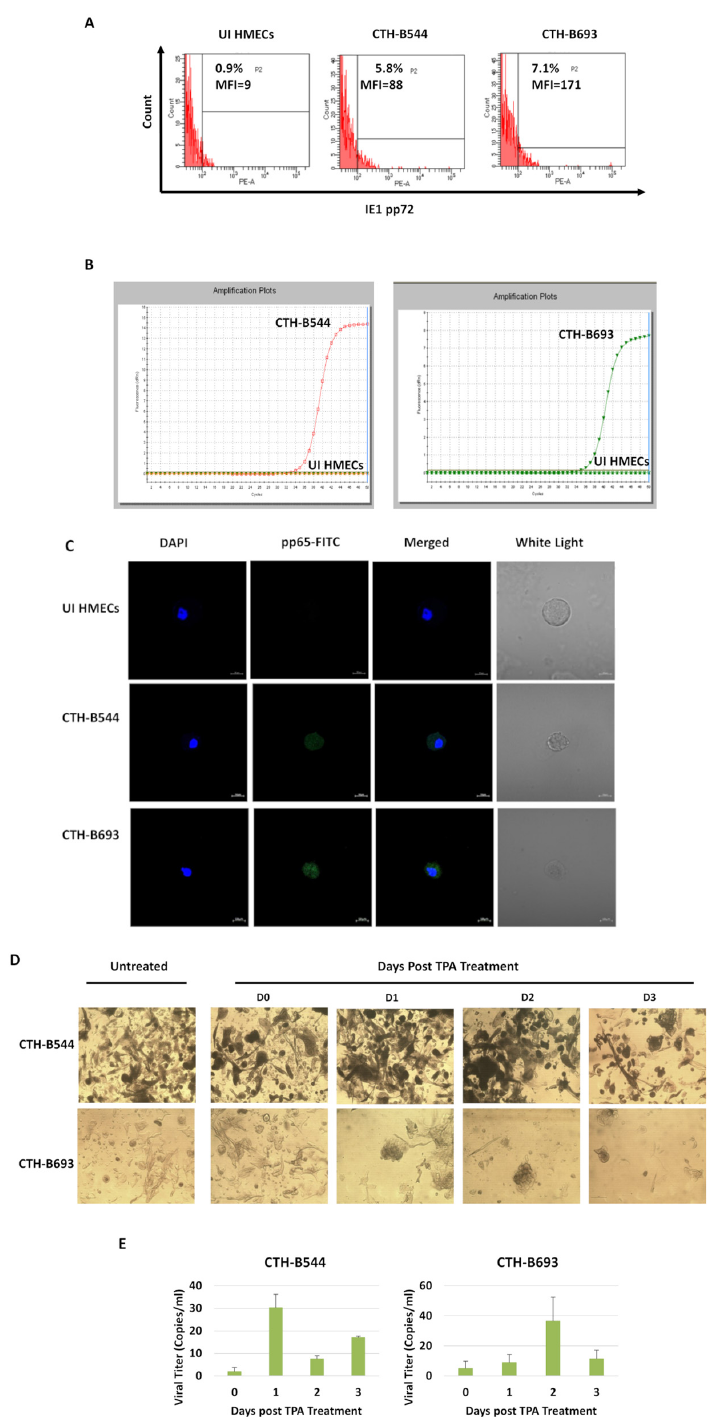
Figure 7. Sustained viral replication in CTH cells. IE1 expression in CTH cells was assessed by ( A ) FACS and ( B ) qPCR. ( C ) pp65 detection in CTH-B544 and B693 cells as demonstrated by confocal microscopy imaging. As a negative control, uninfected HMECs were used; nuclei were counterstained with DAPI; magnification ×63, scale bar 10 μ m. ( D , E ) Determination of viral reactivation from latency in CTH cells through the treatment of TPA. ( D ) Representative images of CTH cultures treated with TPA (100 nM). Untreated cells were used as a control. Magnification ×100, scale bar 100 μ m. ( E ) HCMV lytic replication was induced by TPA in CTH cultures. Histograms represent the mean data ± SD of three independent experiments.